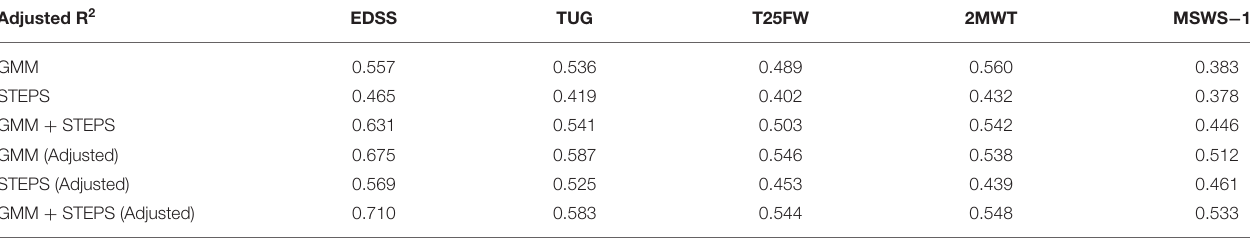
TABLE 2 | Comparison of GMM model and STEPS with conventional clinic-based and patient-reported outcomes. Adjusted R